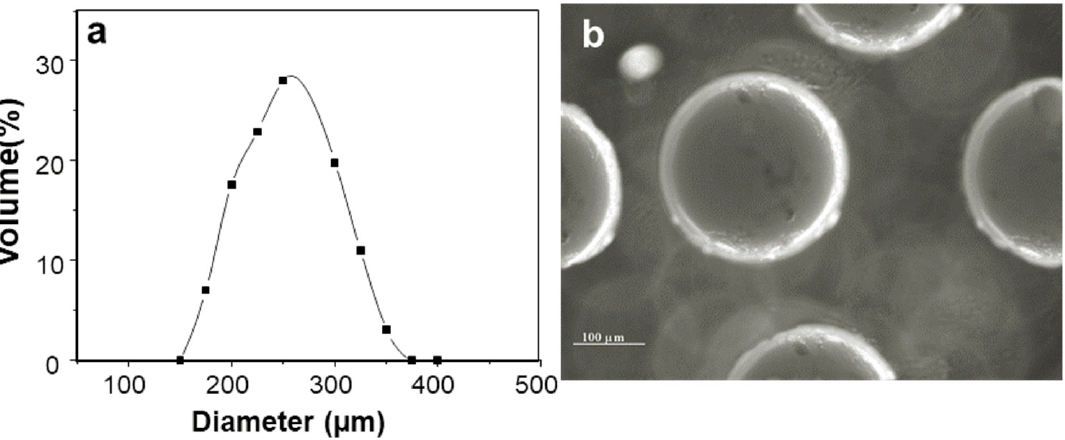
Figure 1. Characterization of insulin-loaded AX microcapsules: ( a ) diameter distribution; ( b ) contrast optical microscope observation.